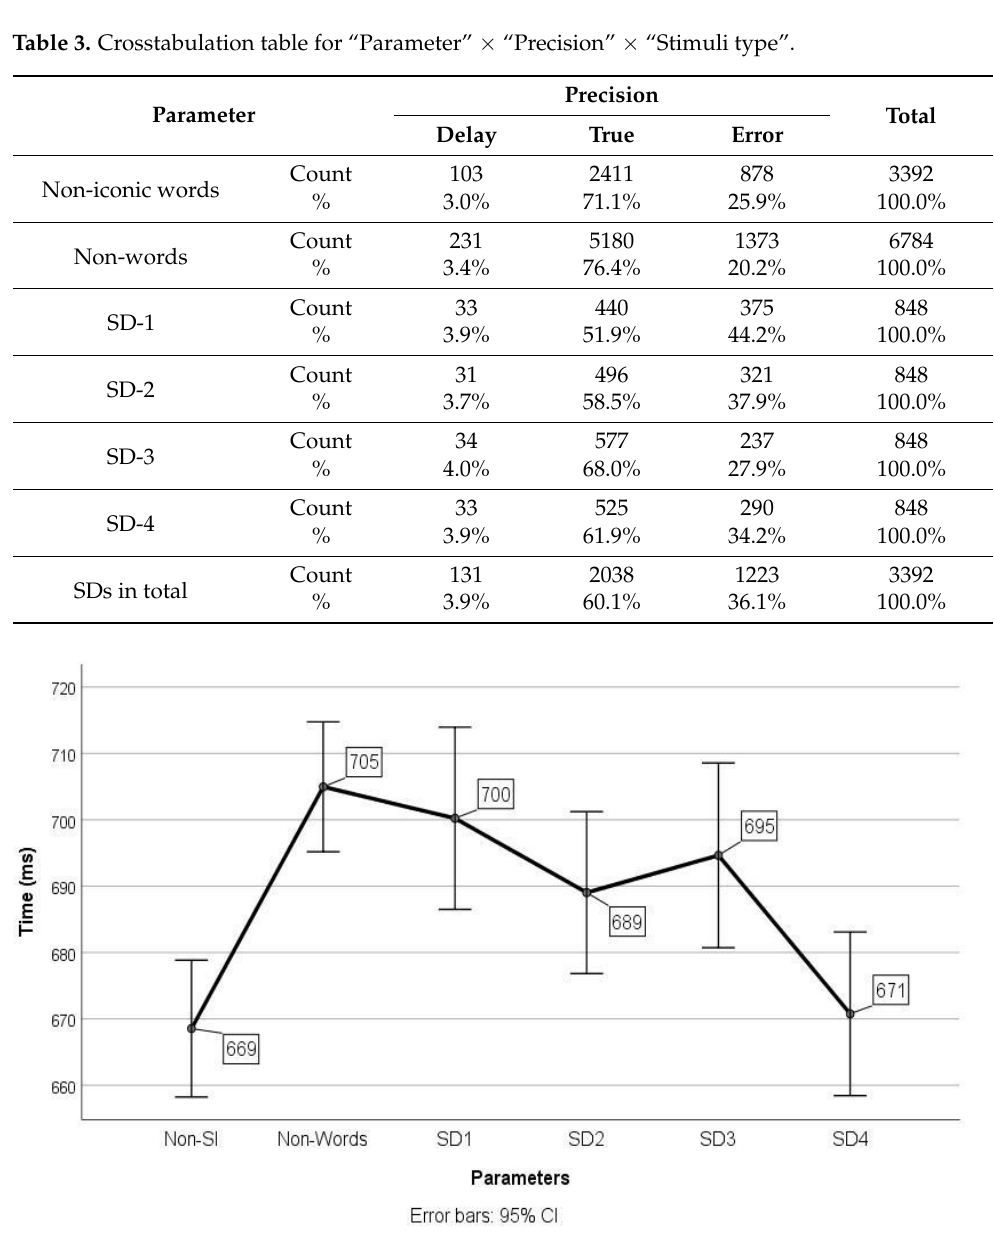
Table 3. Crosstabulation table for “Parameter” × “Precision” × “Stimuli type”.